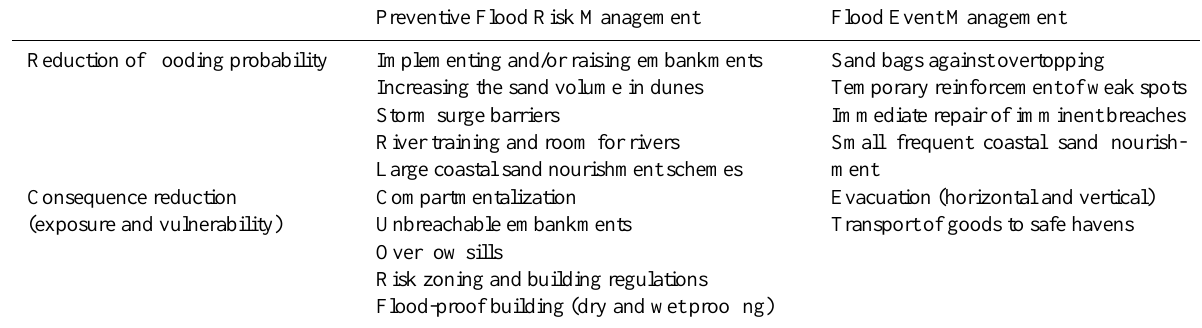
Table 1. Examples of flood risk reducing measures (after Klijn and De Grave, 2008) that were incorporated in the strategic